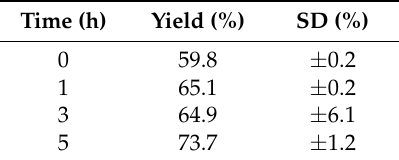
Table 1. Yield for each time point of the